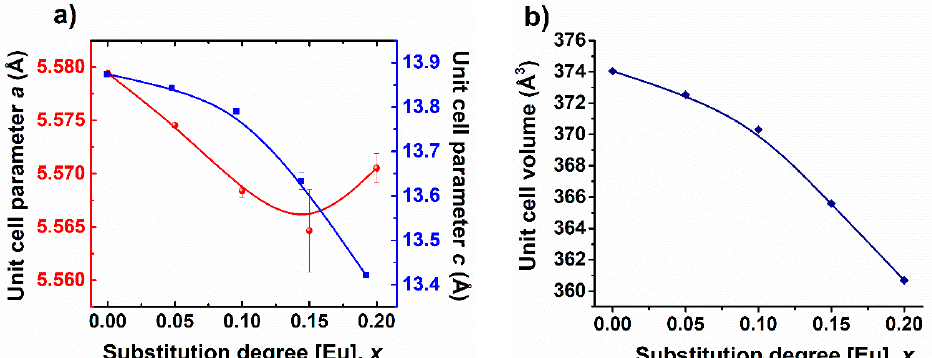
Figure 4. ( a ) Unit cell parameters corresponding to R3c polymorph, and ( b ) unit cell volume for Bi 1 − x Eu x FeO 3 calcined powders.